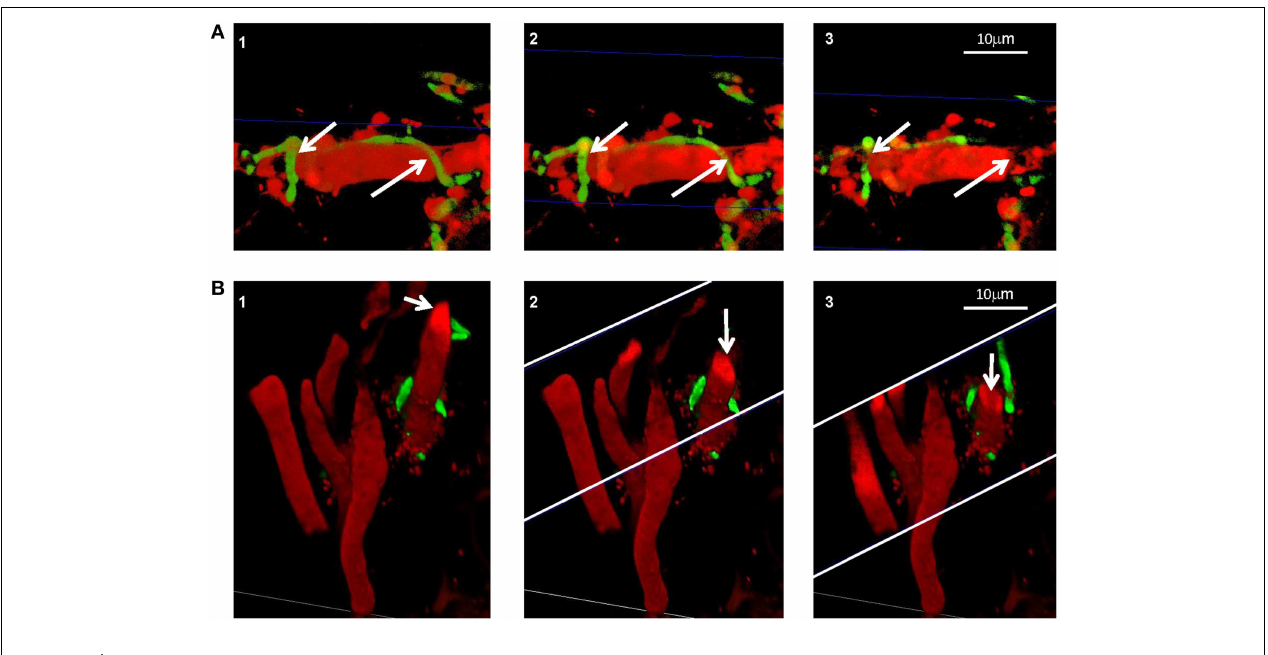
FIGURE 4 | P. aphidis as an ectoparasite. Confocal microscopic analysis of cucumber cotyledons treated with propidium iodide 10 days after treatment with GFP-tagged P. aphidis (green) and 7 days after inoculation with P. xanthii (red). (A) Reconstructed 3D images demonstrating P. aphidis (green; marked with white arrows) coiling around the powdery mildew hyphae and cross-sections (marked with